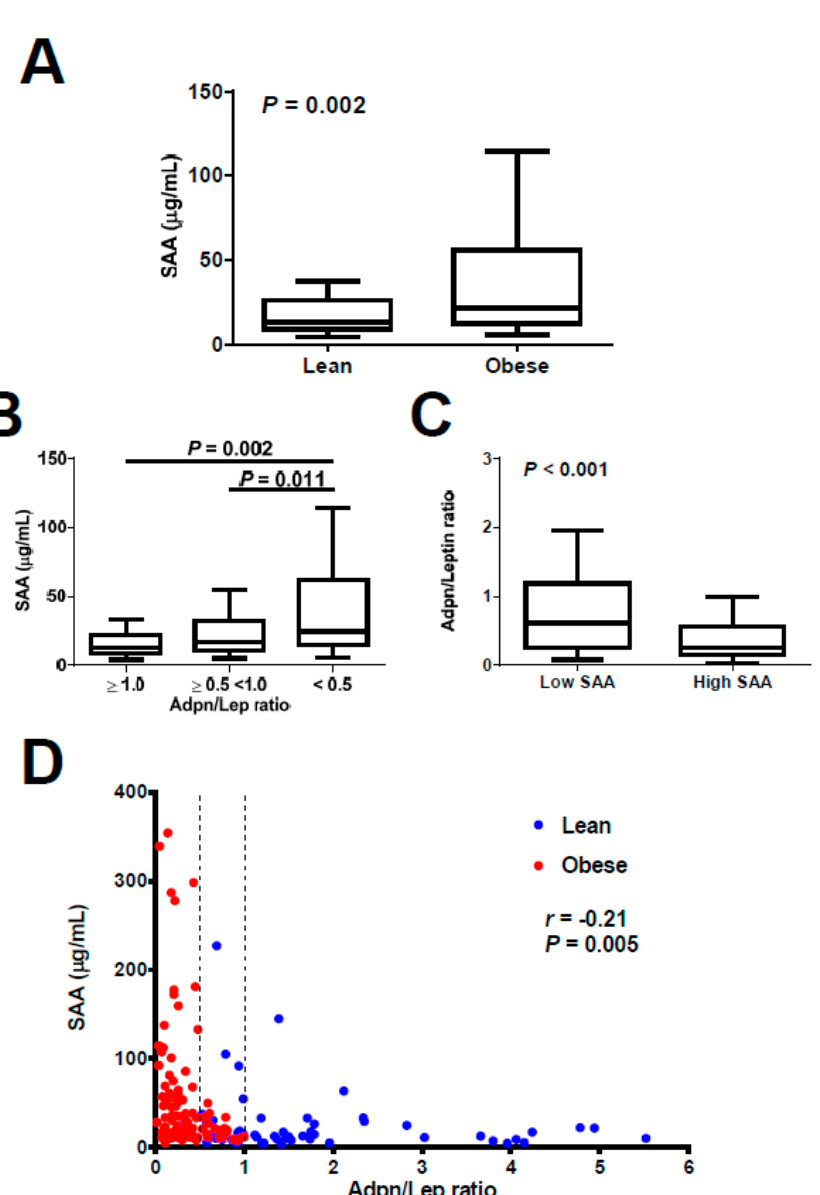
Figure 2. ( A ) Comparison of serum serum amyloid A (SAA) concentrations between lean ( n = 60) and obese ( n = 111) individuals. Statistical differences were analyzed by two-tailed unpaired Student’s t test. ( B ) Serum levels of SAA according to Adiponectin/Leptin (Adpn/Lep) ratio: ≥ 1.0 ( n = 36), ≥ 0.5 <1.0 ( n = 41) and <0.5. ( n = 94). Statistical differences were analyzed by one-way ANOVA followed by Fisher’s LSD test. Box in ( A ) and ( B ) represents interquartile range and median inside, with whiskers plotted according to the Tukey method. ( C ) Adpn/Lep ratio according to serum concentrations of SAA (low SAA, n = 104; high SAA n = 67). Statistical differences were analyzed by two-tailed unpaired Student’s t test. ( D ) Scatter diagram showing the correlation between circulating concentrations of the Adpn/Lep ratio and SAA. Pearson’s correlation coefficient and p value are indicated. Vertical discontinuous lines denote the Adpn/Lep ratio proposed cut-offs of 0.5 and 1.0.